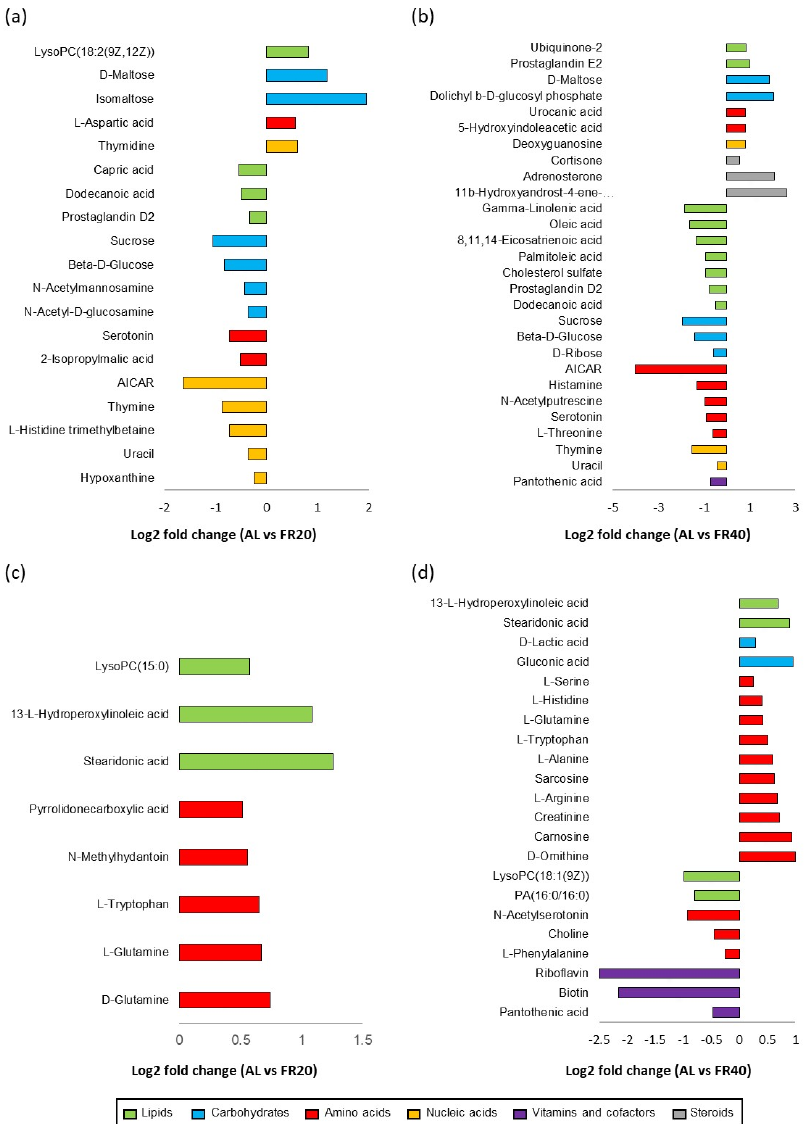
Figure 7. Significantly different metabolites in the cecum and serum of laying hens among normal feeding and restricted feeding group. Different metabolites of AL vs. FR20 in the cecum ( a ), AL vs. FR40 in the cecum ( b ); different metabolites of AL vs. FR20 in the serum ( c ), AL vs. FR40 in the serum ( d ). The accountable metabolites for class discrimination with VIP > 1 and p < 0.05 were listed; the web-based pipeline MetaboAnalyst [33] was used to enrich the relevant KEGG pathways. AL: ad libitum with basal diet; FR20: basal diet with 20% feed restriction; FR40: basal diet with 40% feed restriction.